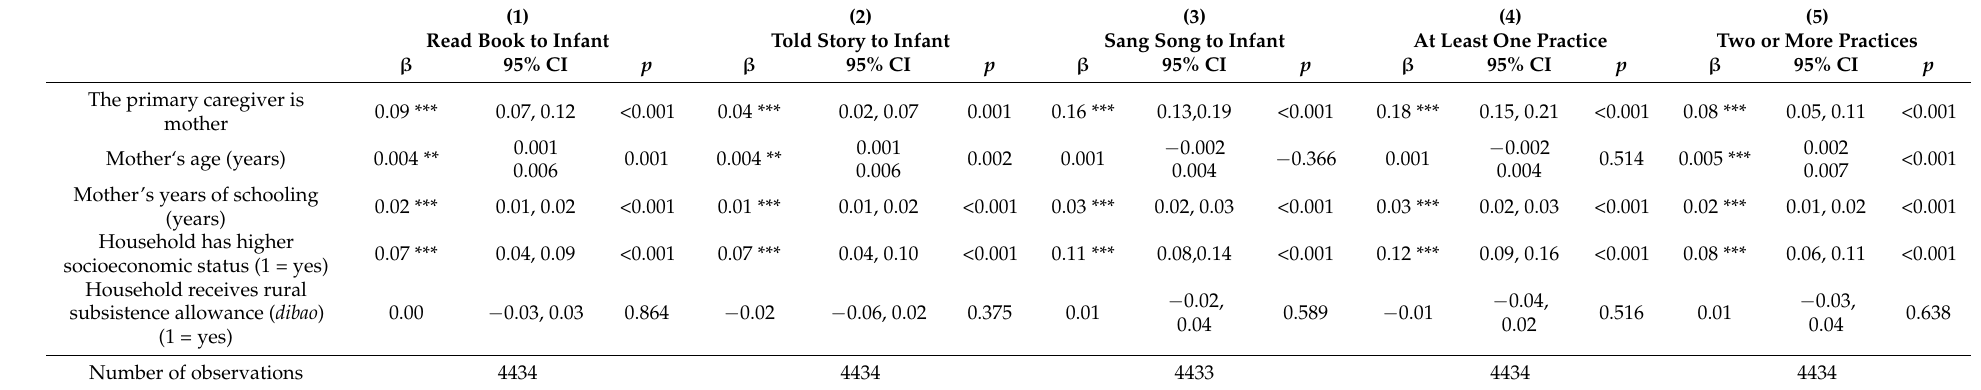
Table 5. Correlations between stimulating parenting practices and household